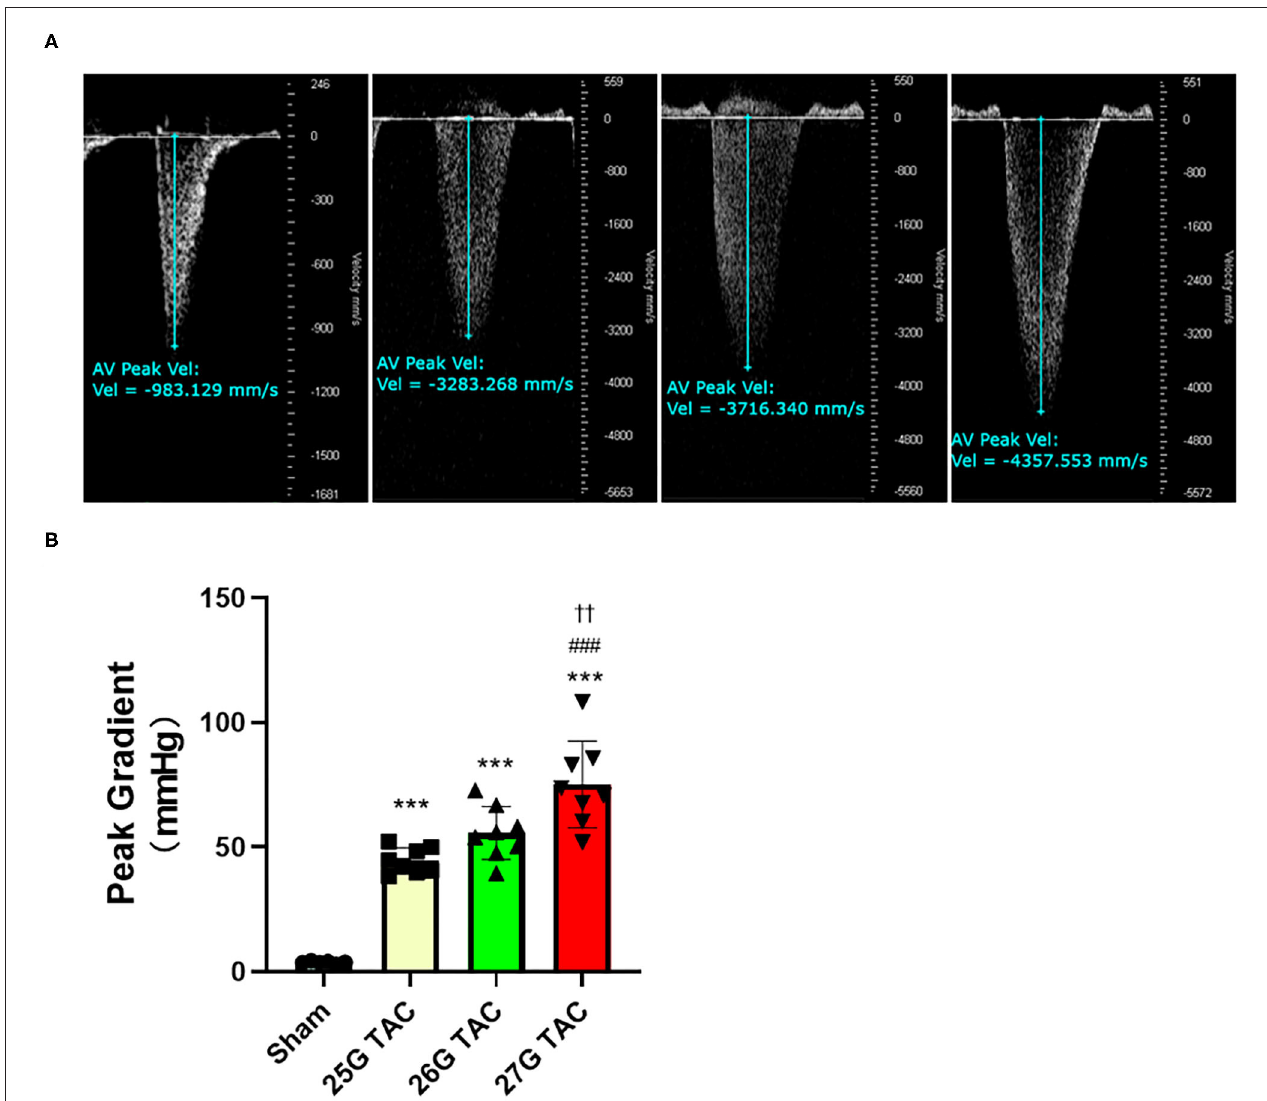
FIGURE 1 | Aortic pressure gradients following 1 week of TAC. (A) Representative pulsed wave Doppler images for sham, 25, 26, and 27G TAC mice after 1 week. (B) Peak pressure gradients calculated from Doppler velocities after 1 week of TAC. *** P < 0.001 vs. sham, ### P < 0.001 vs. 25G TAC, †† P < 0.01 vs. 26G TAC by one-way ANOVA with Tukey’s